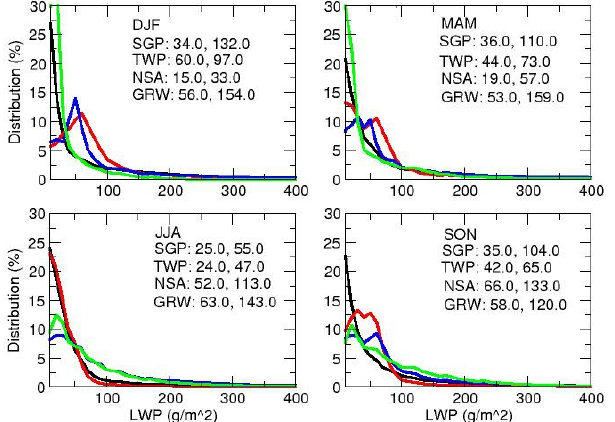
Fig. 10. Seasonal LWP distribution at the 3 fixed sites SGP (black), TWP-C3 (red), NSA (green) and at the AMF1-Azores (blue). The median and 75 percentile of the distributions are also given.